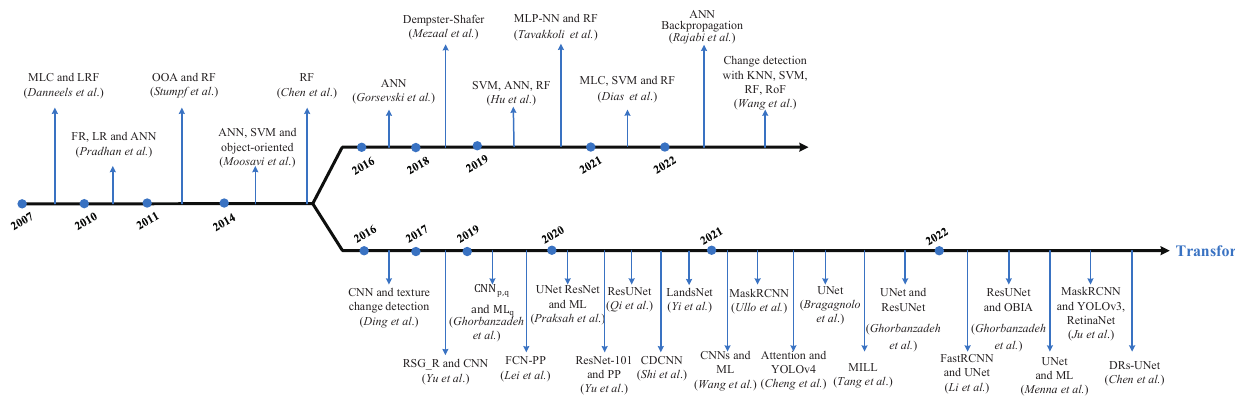
Figure 1. The development of automatic landslide